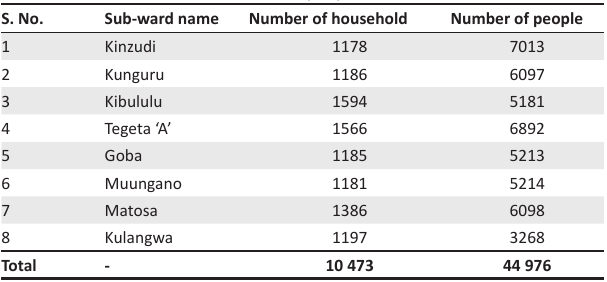
FIGURE 1: Location of study TABLE 1: Household size and number of people. S. No.